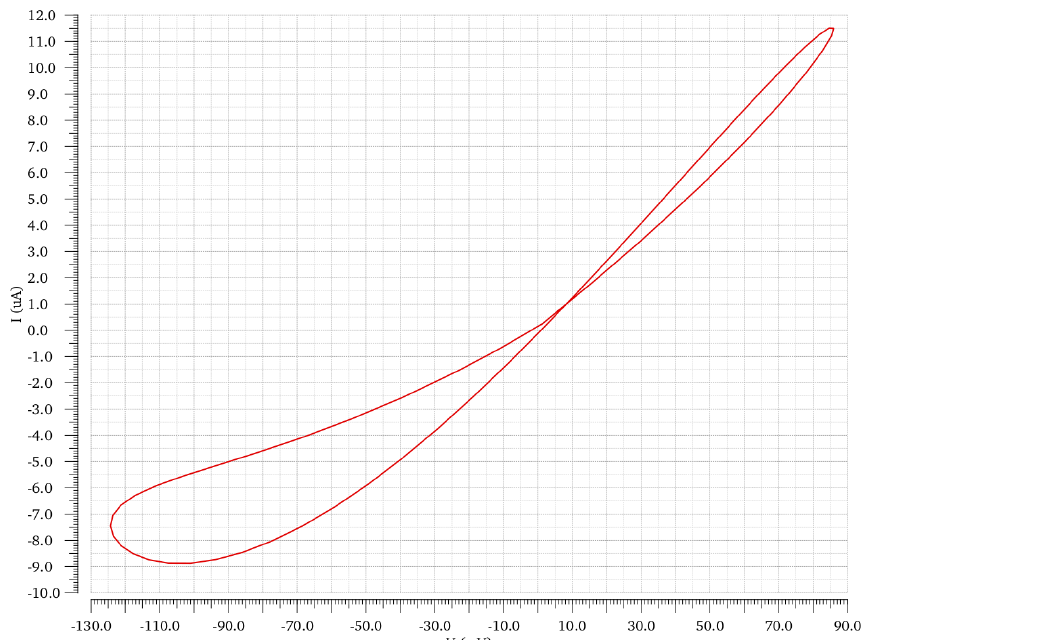
Figure 35. The voltage current characteristics of the proposed memristor for 4MHz. Circuit conditions are V dd of 3 . 3V, and temperature equals 27 ◦ C and on the nominal